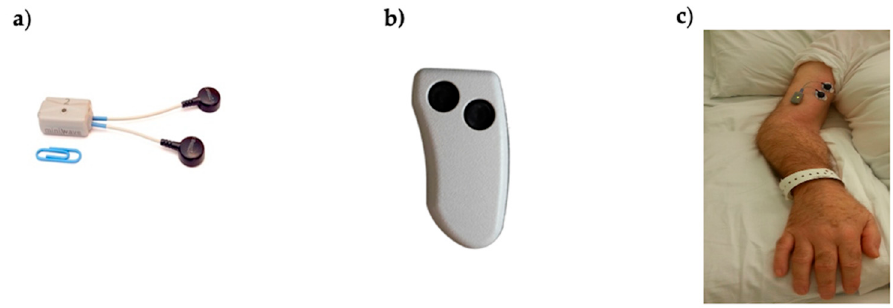
Figure 1. ( a ) Cometa Mini Wave Infinity wearable sEMG probe with embedded accelerometer and onboard memory used in this study; ( b ) remote control used to activate/deactivate probes; ( c ) elec- trodes and probe placed on the biceps brachii of one study